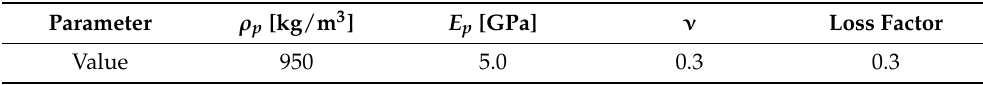
Figure 14. A schematic diagram of the FE model: ( a ) FE model of plate structure with ABHs and damping layers; ( b ) A two-dimensional ABH indentation with varying thickness damping layers; ( c ) A two-dimensional ABH indentation with uniform thickness damping layers. Table 3. Parameters of the damping